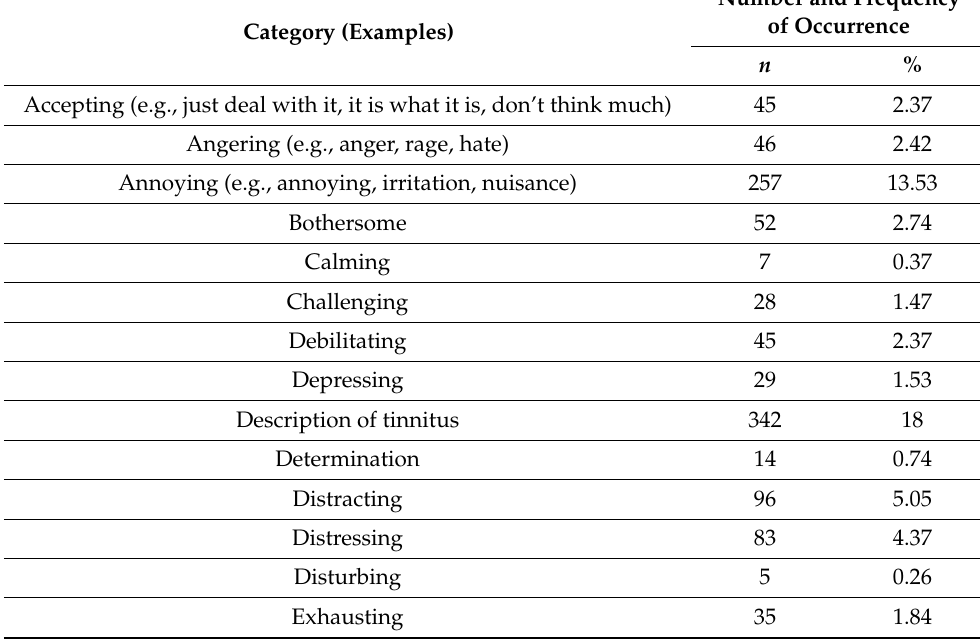
Table 2. Key categories identified by content analysis in alphabetical order.